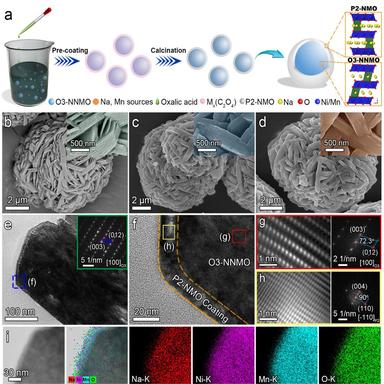
Morphology and surface characteristics of as-prepared cathode materials. (a) Schematic of the synthesis of the proposed heterostructured cathode material. SEM images of (b) the precursor ((OH)2), (c) O3-NNMO, and (d) O3@5% P2. (e) TEM image and corresponding SAED pattern, (f–h) HRTEM image alongside their corresponding fast Fourier transforms, and (i) EDS mappings of O3@5% P2.